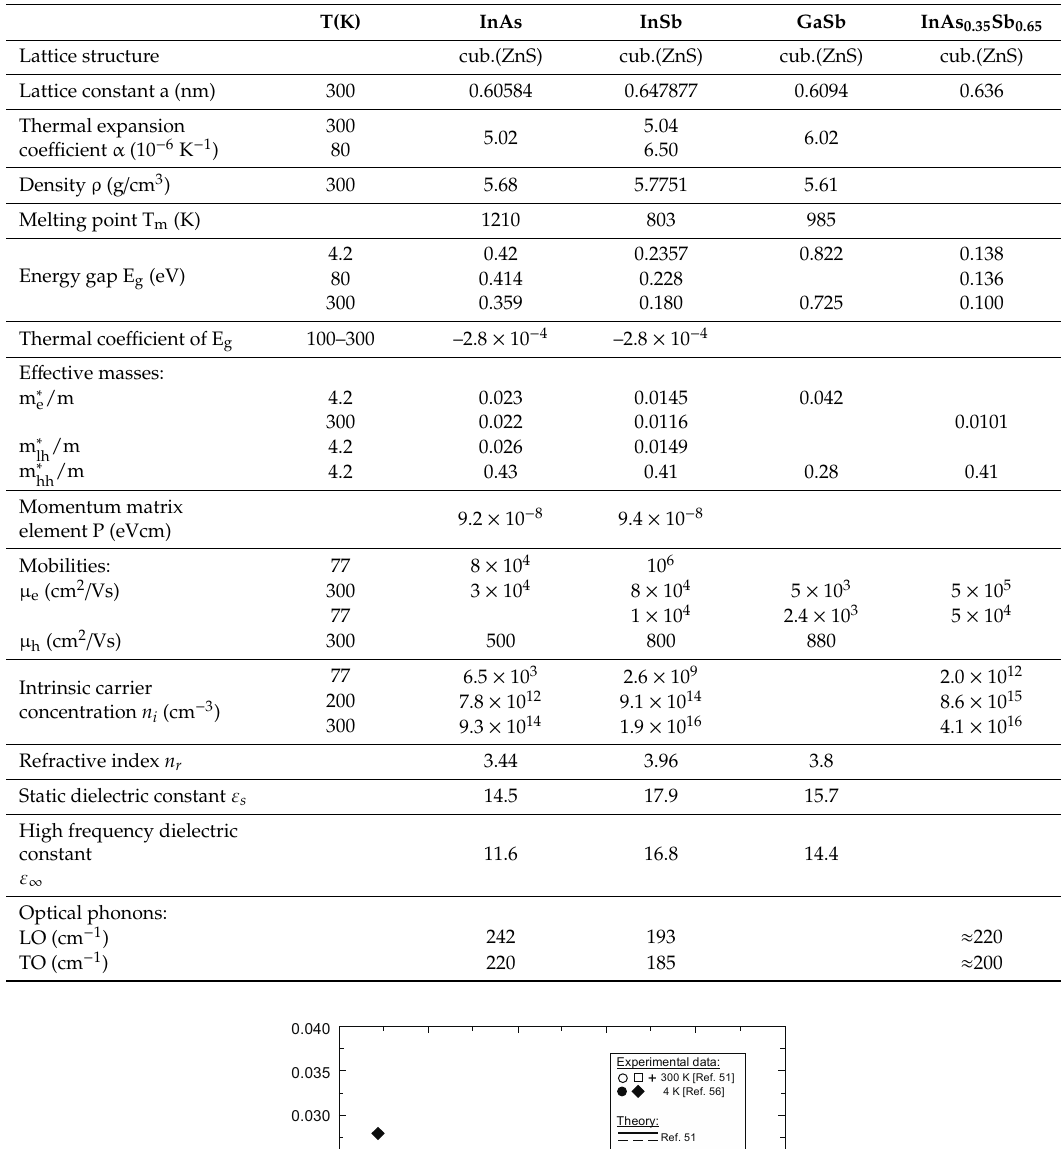
Table 3. Physical properties of narrow gap III–V alloys.